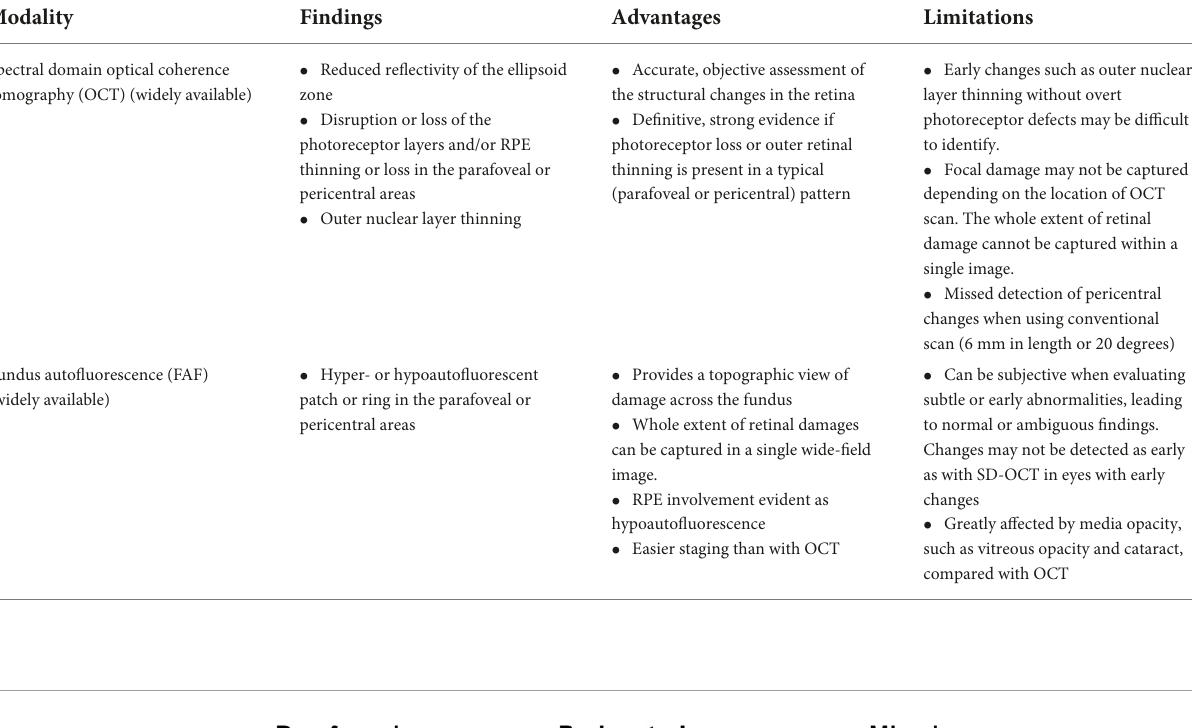
TABLE 1 Findings, advantages, and limitations of the conventional, widely available imaging modalities used for screening hydroxychloroquine retinopathy.